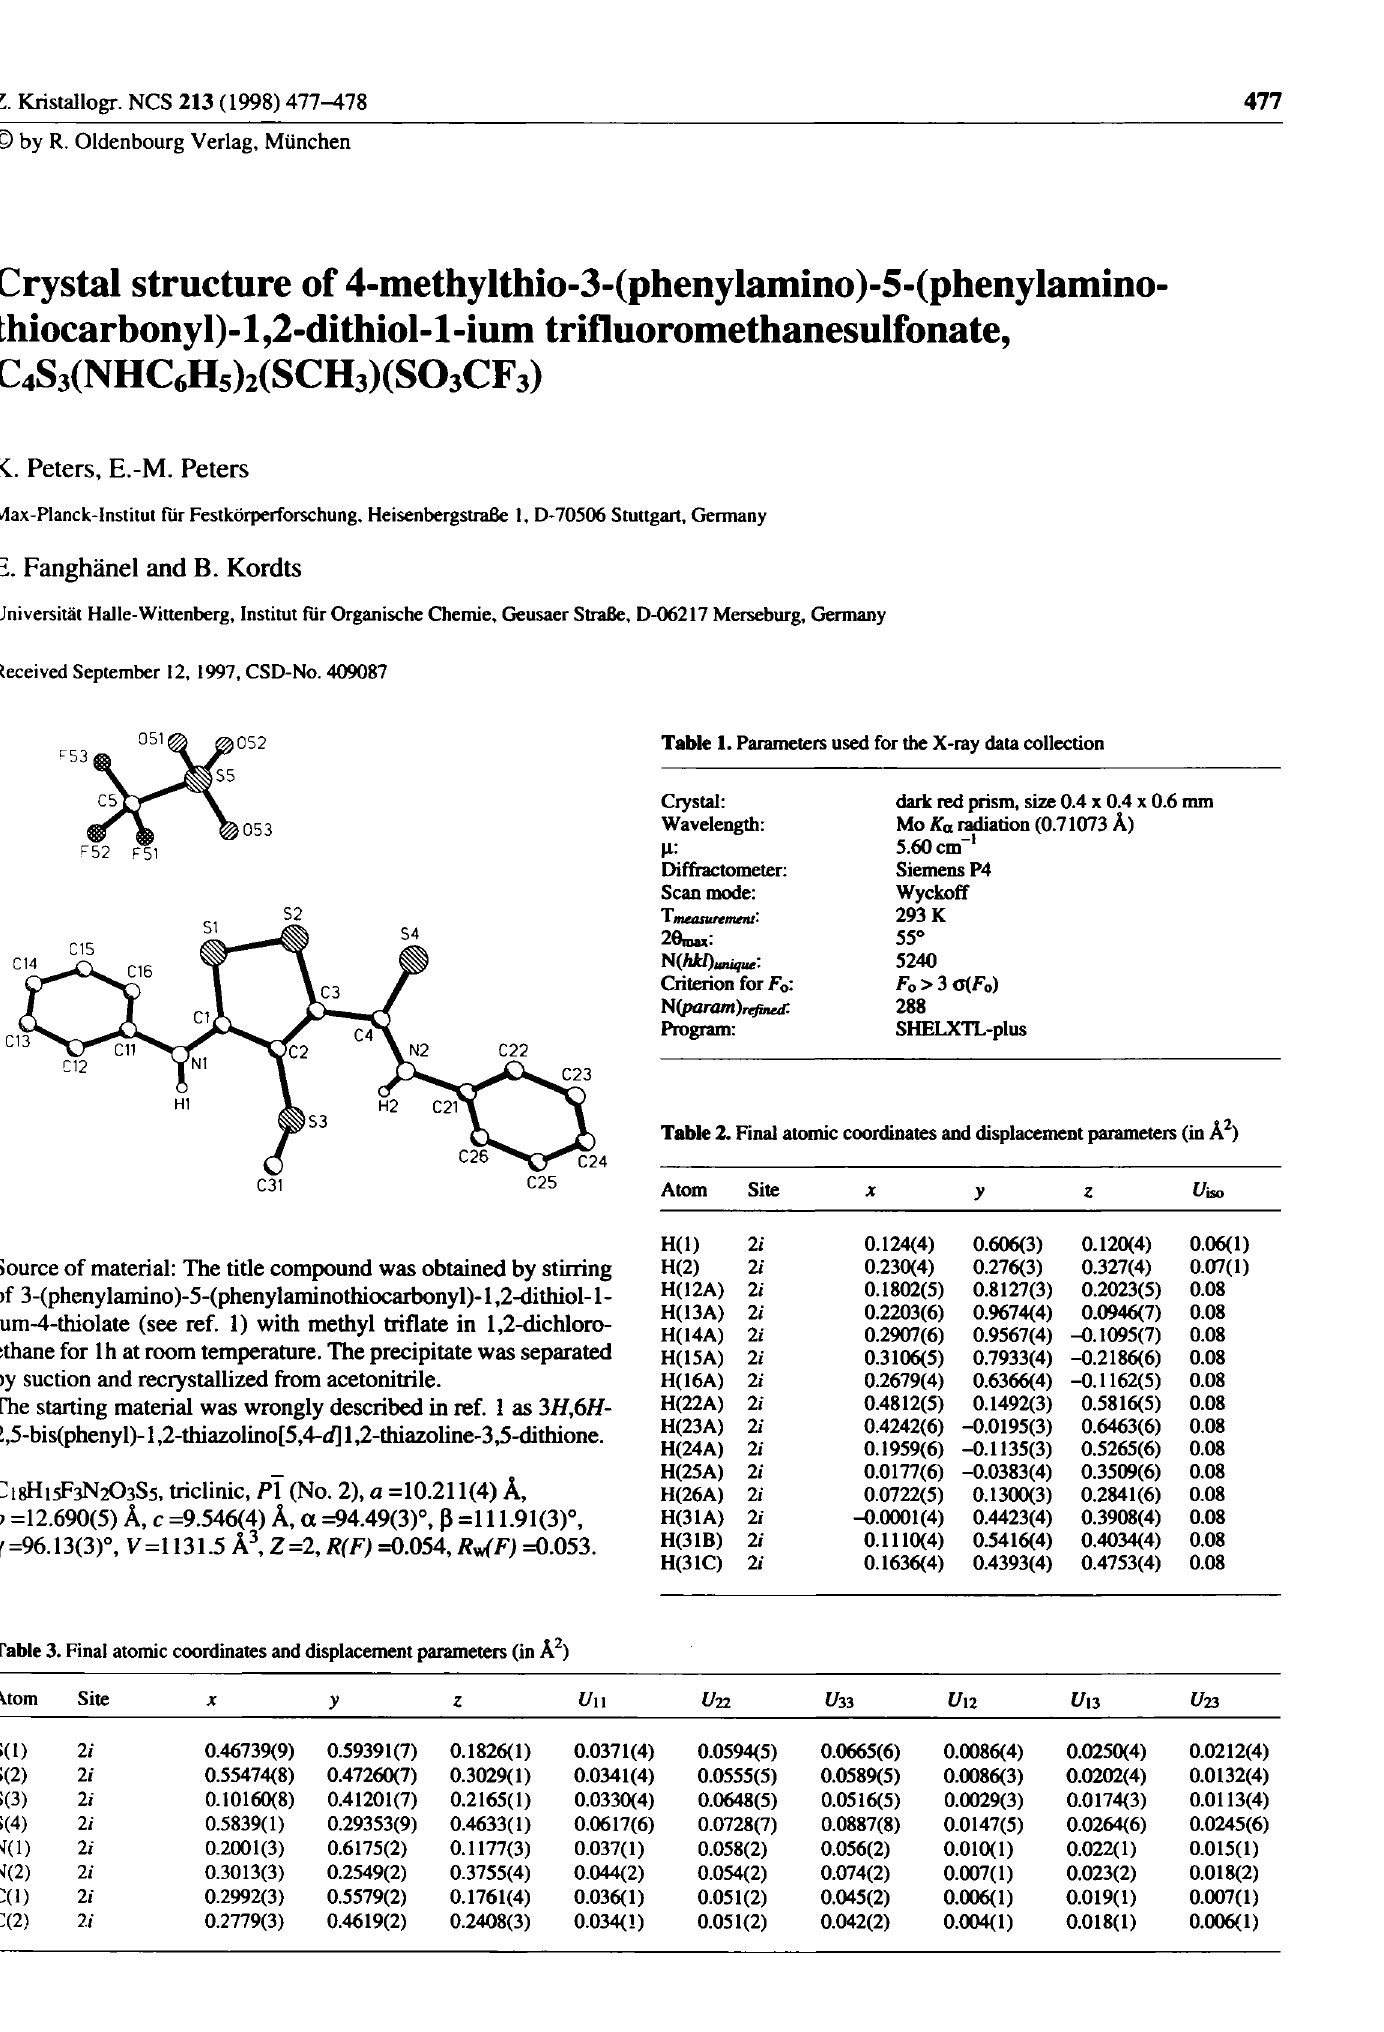
Table 3. Final atomic coordinates and displacement parameters (in Â^) Atom